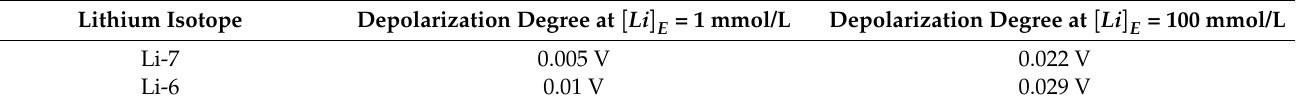
obtained. See Table 29. Table 29. The table shows the depolarization degree based on the quantum transport of lithium isotopes as in graph (b) of Figure 10.